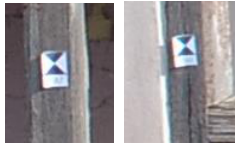
Figure 4. Example of the control points Images processing done by ContextCapture (Bentley)